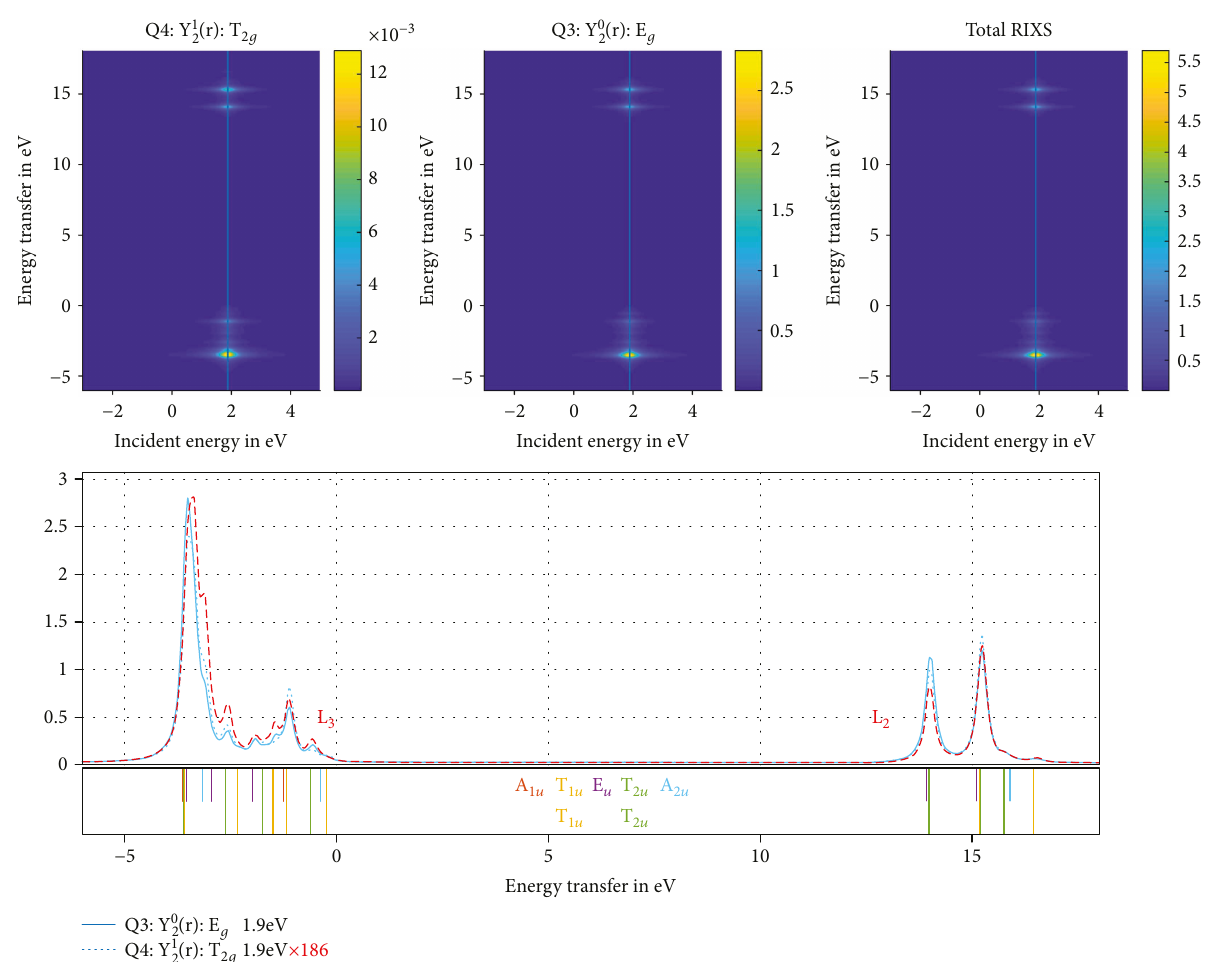
Figure 20: Calculated 1s2p RIXS for the ion Ni 2+ (3d 8 ) for 10D q =0.9eV. As can be seen in the map re fl ecting the quadrupole IRREP T row, left), the contribution to the spectrum is nonzero because of the small 3d spin-orbit interaction leading to a weak mixing of the states. However, its contribution is about 186 times weaker and thus neglectable in fi rst